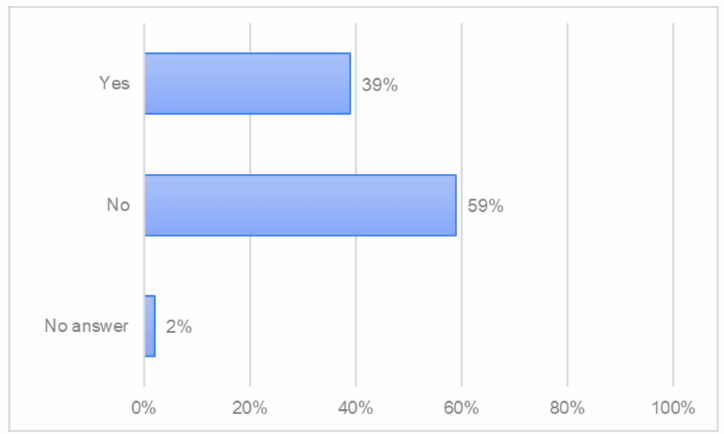
Figure 8. Summary of damage to the sight of tree climbers at working with the power saw.